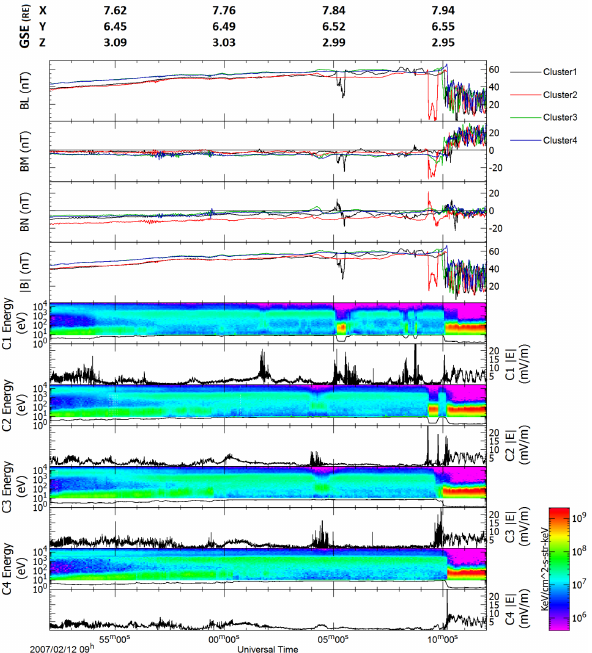
Figure 3. Cluster four-spacecraft observations between 09:52UT and 10:12UT: on the top abscissa, the position of reference space- craft, Cluster 3, is noted for different times. The top four panels show the magnetic field data observed by Cluster FGM in a bound- ary normal coordinate system, B L , B M and B N components, plus the magnitude of the field, in Cluster standard colour code (C1: black, C2: red, C3: green, C4: blue). The bottom four panels show omnidirectional differential energy flux spectrograms from PEACE data (black line represents the spacecraft potential) along with elec- tric field from EFW data on C1, C2, C3 and C4 respectively. The signatures of two separated transient structures consist of a bipolar B N and the appearance of low-energy electron populations are seen before crossing the magnetopause. One is predominately observed by C1 at 10:05–10:06UT and the other by C2 at 10:09–10:10UT; for the former signature, C2 and C3 also observed similar low- energy electrons between 10:04 and 10:05UT. All four spacecraft crossed the magnetopause at ∼ 10:10UT. (See Sect. 4.2 for more